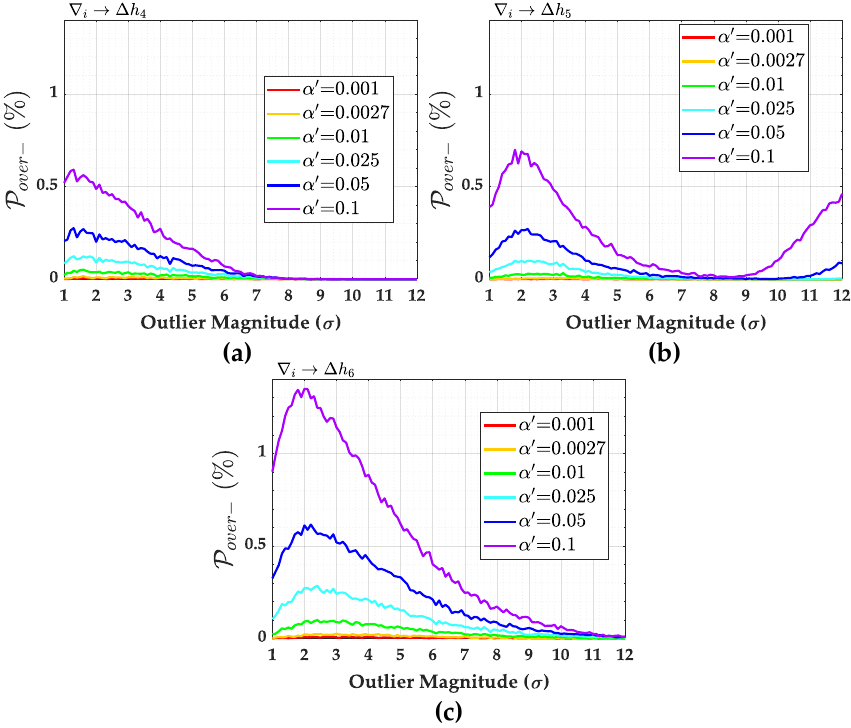
Figure 23. Probability of over-identification ( P over − ) for network ( b ). ( a ) P over − for ∆ h 4 . ( b ) P over − for ∆ h P over − for ∆ h 5 . ( c ) 6